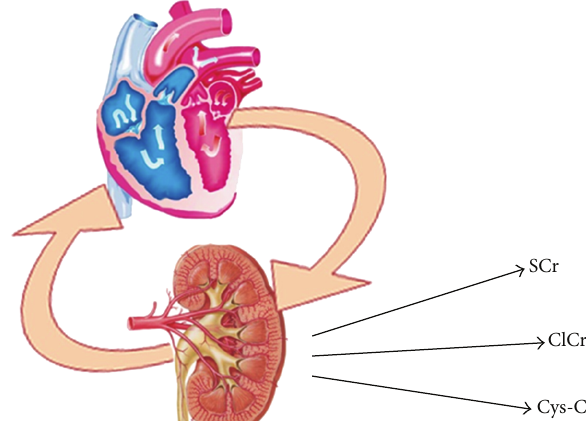
Figure 2: The concept of cardiorenal syndrome that often brings the insaturation of a vicious circle is graphically explicated. SCr: Serum Creatinine; ClCr: Clearance of Creatinine; Cys-C: Cystatine-C.